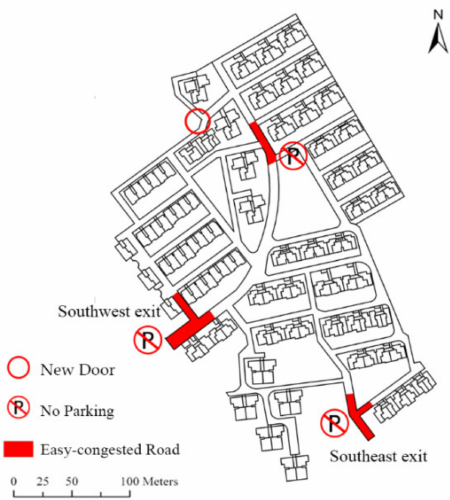
Figure 11. Easy-congested road sections in Luoshanqicun Community, Pudong New District, Shanghai,